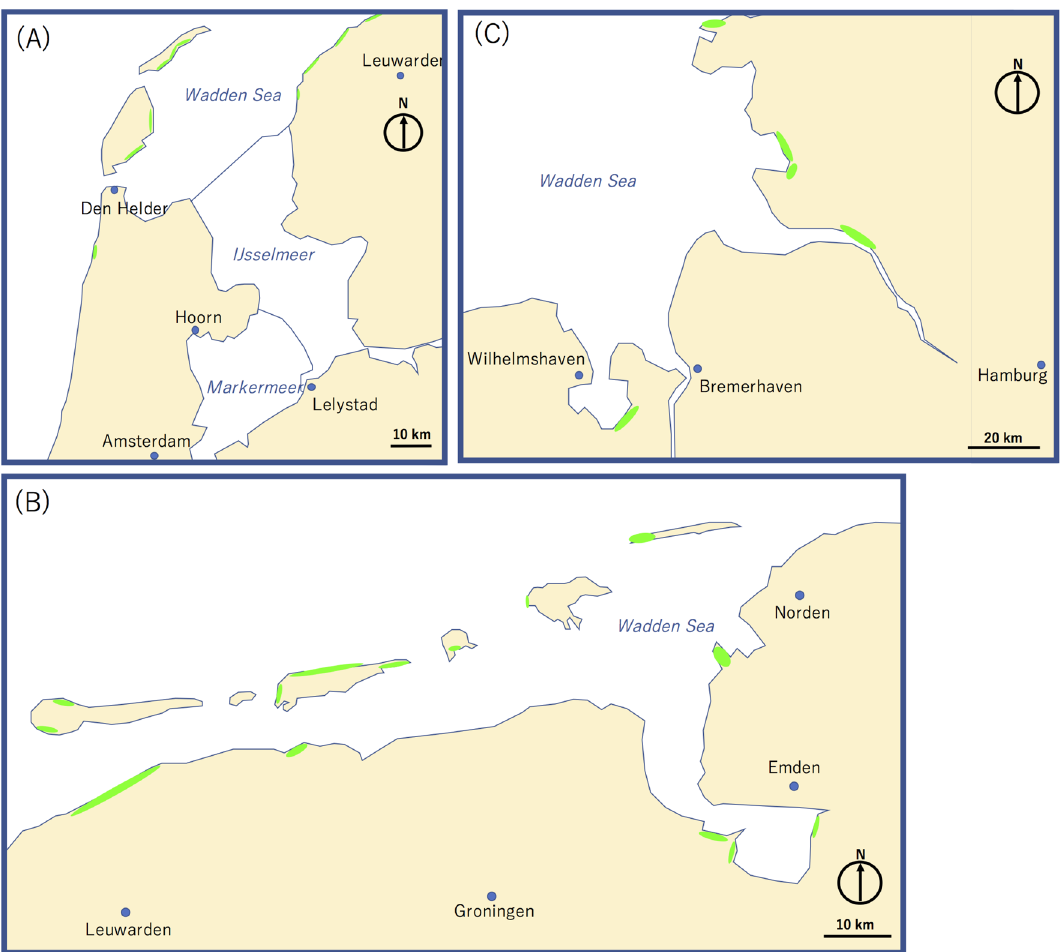
Figure 12. Possible locations of HKMSDD-MSMs in Wadden Sea. The region near Amsterdam ( A ), near the Netherlands-Germany border ( B ), and in the northwest part of Germany ( C ) are shown. The green areas indicate regions that are sufficiently lower than sea level (< − 2 m) along the shore lines, which would be appropriate for the proposed HKMSDD-MSM technique. HKMT drew this map with Microsoft PowerPoint software and holds the